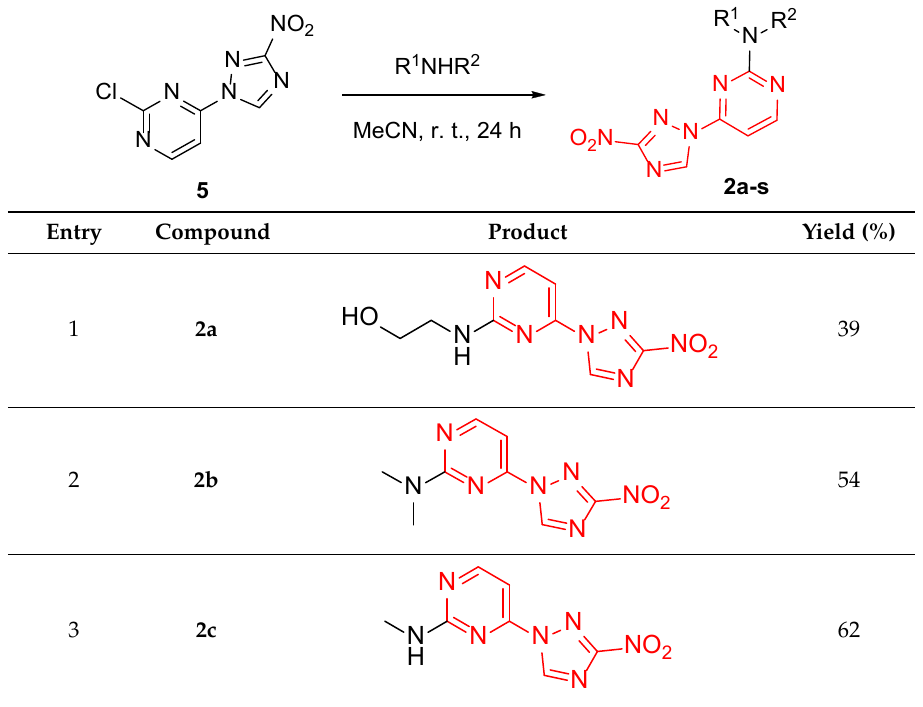
Table 2. Synthesis of 4-(3-nitro-1,2,4-triazol-1-yl)pyrimidines 2a-s .